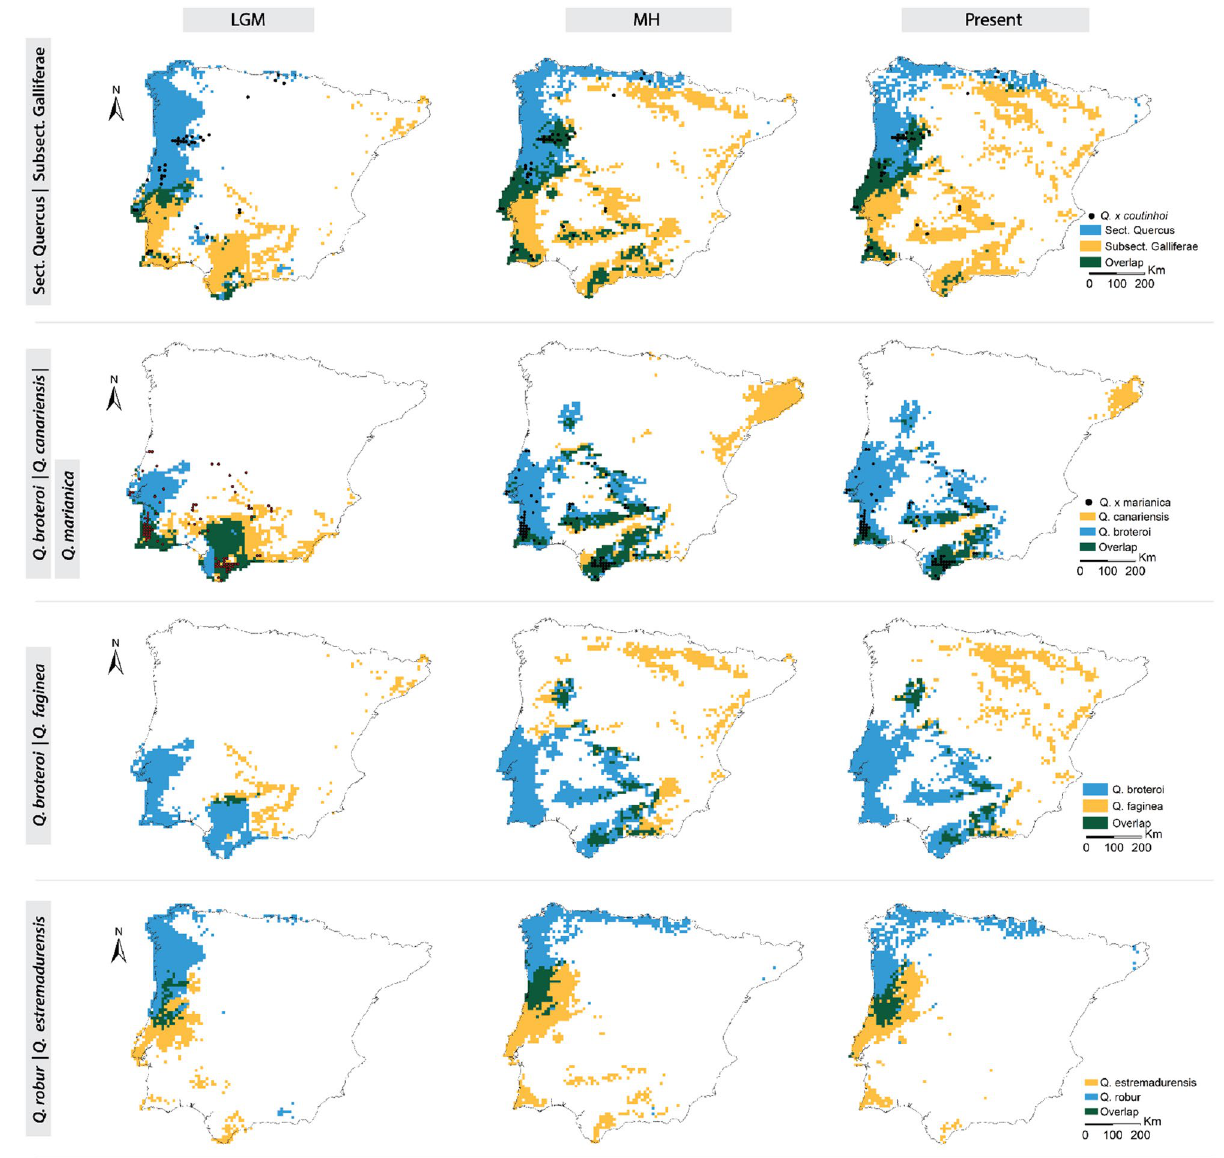
Figure 5. Distribution of the contact zones (green) of main targeted taxa across time periods. LGM (left), MH (center), and the present (right), and current distribution of hybrids ( Q. × coutinhoi and Q. × marianica ). Sect. Quercus refers to the roburoid oaks ( Q. robur and Q. estremadurensis ) and Subsection Galliferae refers to the Gall oaks ( Q. broteroi and Q. faginea ) (Colours were chosen in way to enhance visual discrimination of different groups and their overlap). Maps were generated by JG and CVV in R v.4.0.3 (https ://www.r-proje ct.org) and assembled in ArcMap 10.5 (https ://www.esri.com/en-us/arcgi